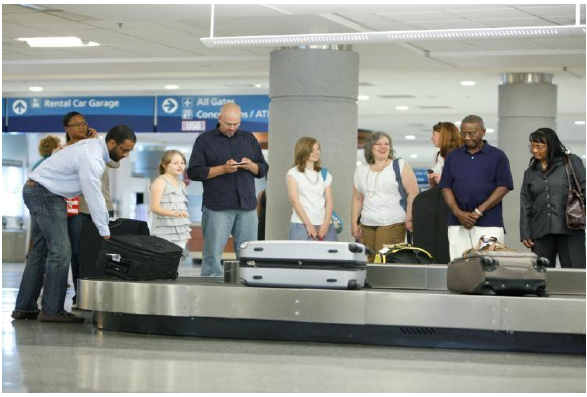
Figure 12. Before detection [62].